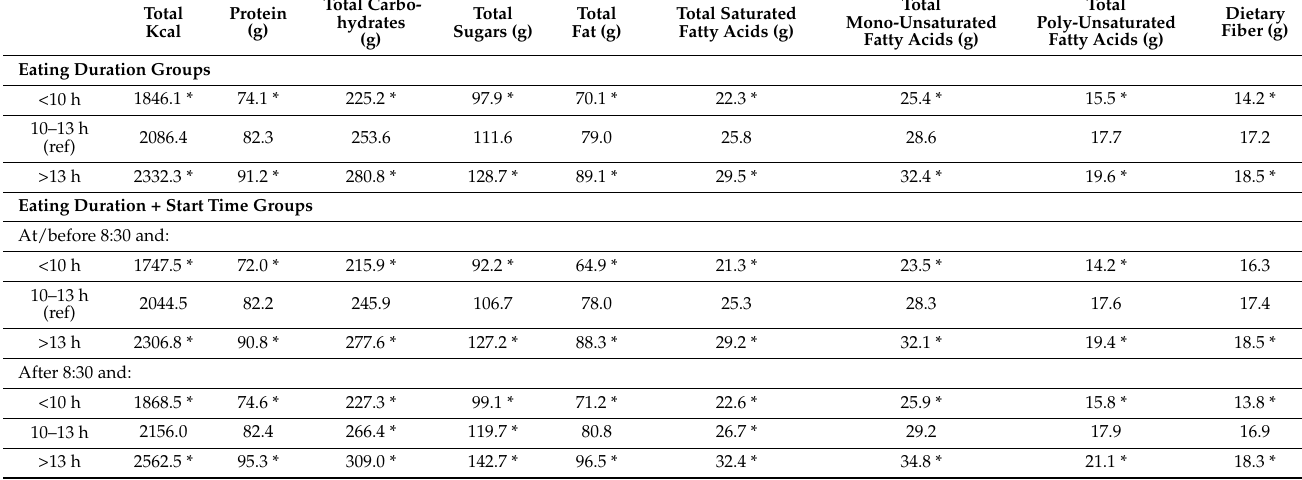
Table 3. Weighted means for 2-day average kcal and nutrient intake by eating duration groups and by eating duration groups split at mean start time.